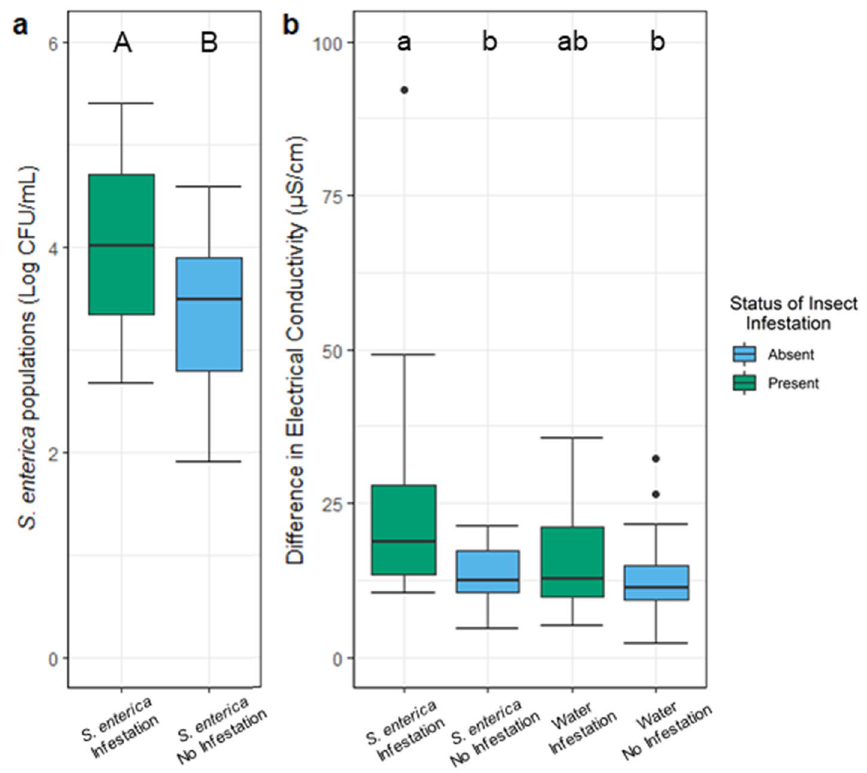
Figure 3. Macrosteles quadrilineatus infestation on S. enterica inoculated tomato plants led to heightened bacterial populations ( a ) and electrical conductivity ( b ) than plants absent insect infestation. Plants inoculated with either S. enterica or water (mock) were infested by adult M. quadrilineatus or remained absent of insects. Empty clip cages were applied for treatment groups with no infestation. Electrical conductance was calculated by subtracting the final from the initial measurement for damaged and undamaged leaf discs and were used to evaluate the extent of electrolyte leakage over six hours. Each treatment group contains combined data from the tip, middle, and basal regions of leaves. Salmonella enterica populations were measured on water inoculated leaves but yielded 0 CFU and were thus excluded from the figure. Letters above boxplots indicate significant differences between treatment groups within each experiment ( P < 0.05) as detected by a one-way ANOVA. Singular dots represent an outlier